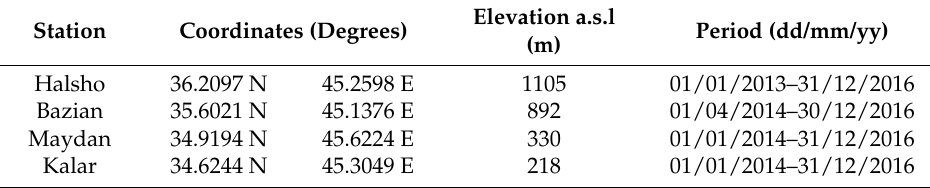
Table 3. Automatic stations as data in Table 2, plus